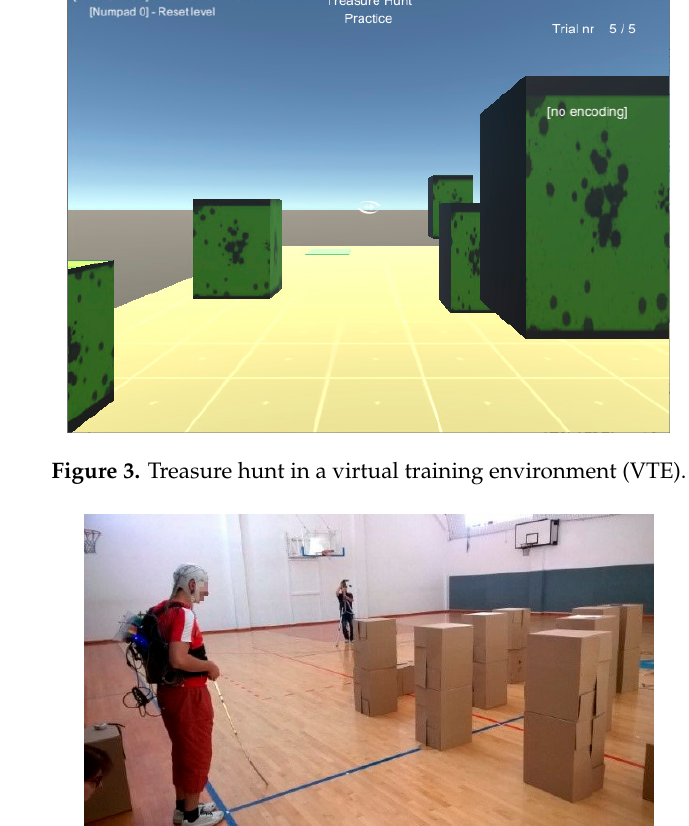
Figure 4. Treasure hunt in RW.